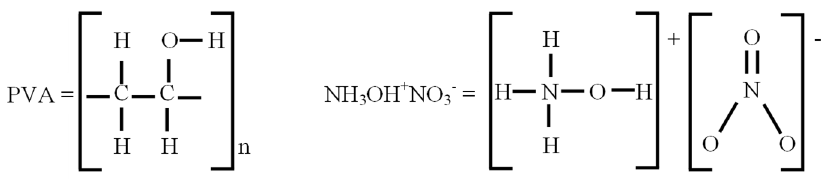
Figure 1. Molecular structure of polyvinyl alcohol (PVA) on the left and hydroxylamine nitrate (HAN) on the right.